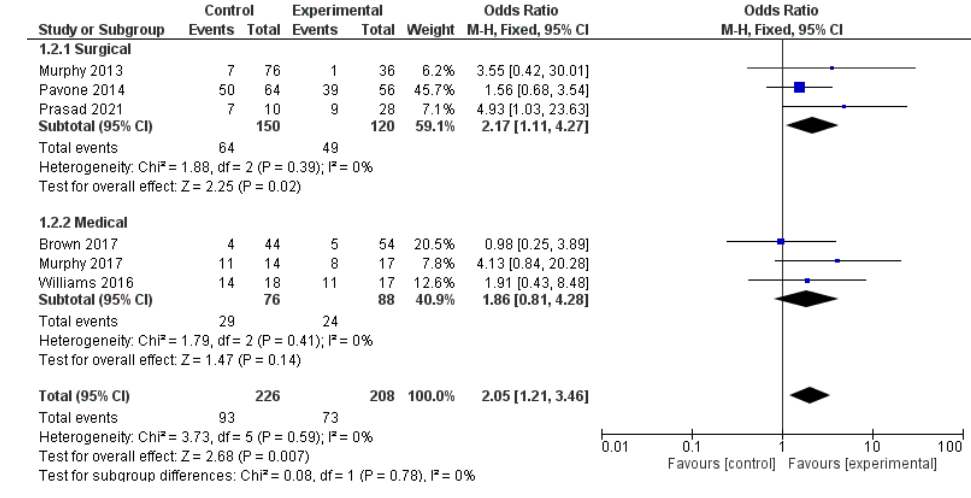
Figure 5. Forest-plot